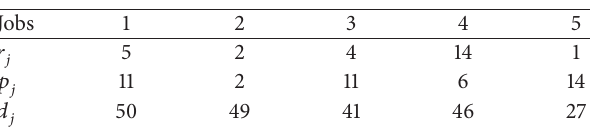
Figure 5: Preemption-based adjustment of 𝑟 1 (Example 1). Table 3: Data of the 5-job instance of Example